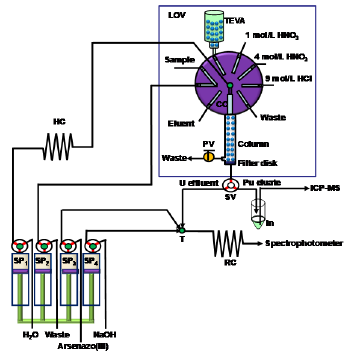
Figure 8. Schematic deposition of lab-on-valve (LOV) sequential injecting system renewable chromatographic separation [27]. HC: holding coil, PV: pinch valve, RC: reaction coil, SP: syringe pump, SV: solenoid valve, T: confluence point.